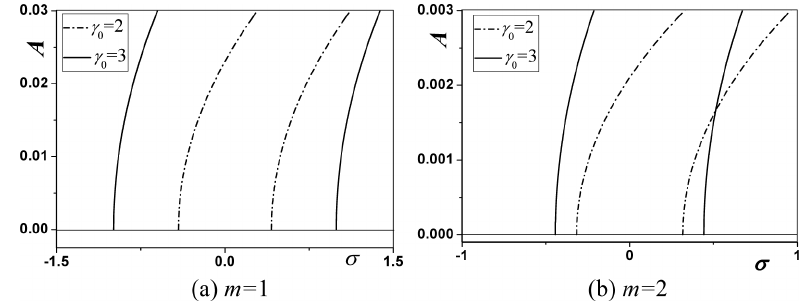
Fig. 4. Effects of the mean axial speed: Eq. (14).